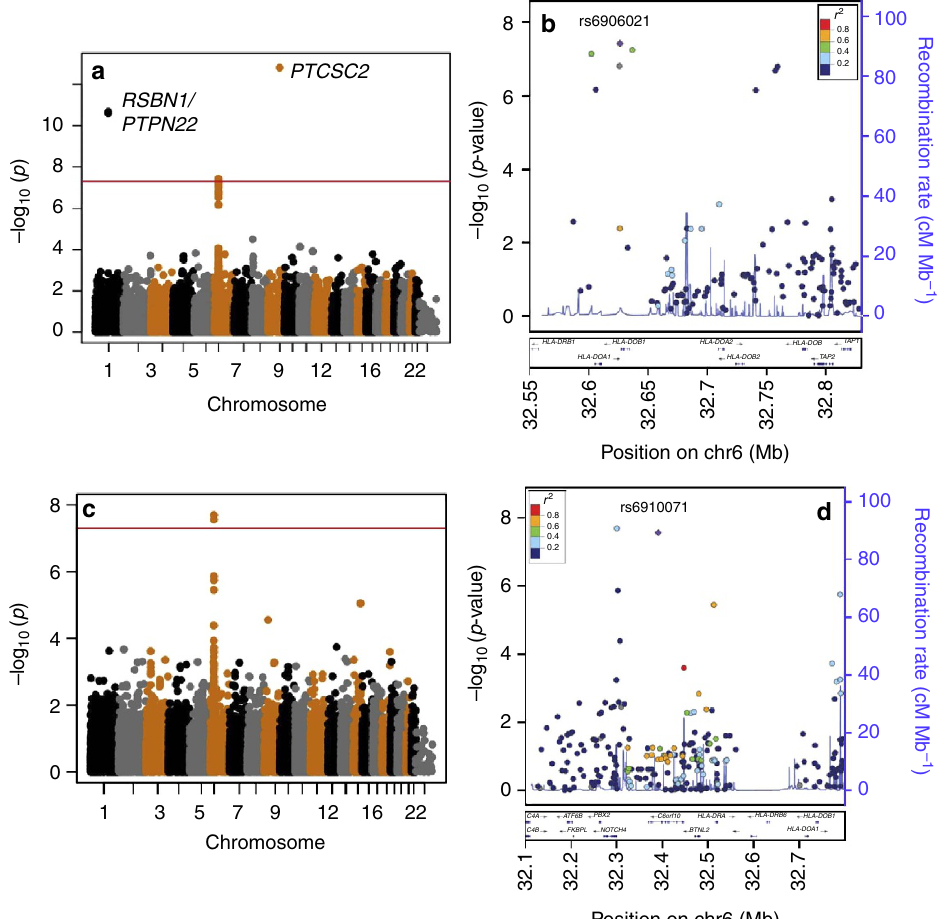
Figure 2 | SNP association analysis for hypothyroidism and polymyalgia rheumatica. All analyses used an additive genetic model adjusted for three principal components, age and sex. ( a ) Manhattan plot for the hypothyroidism phenotype (3,242 cases, 6,484 controls) and ( b ) LocusZoom plot highlighting SNP rs6906021. ( c ) Manhattan plot for polymyalgia rheumatica (413 cases, 5,782 controls) and ( d ) LocusZoom plot highlighting SNP